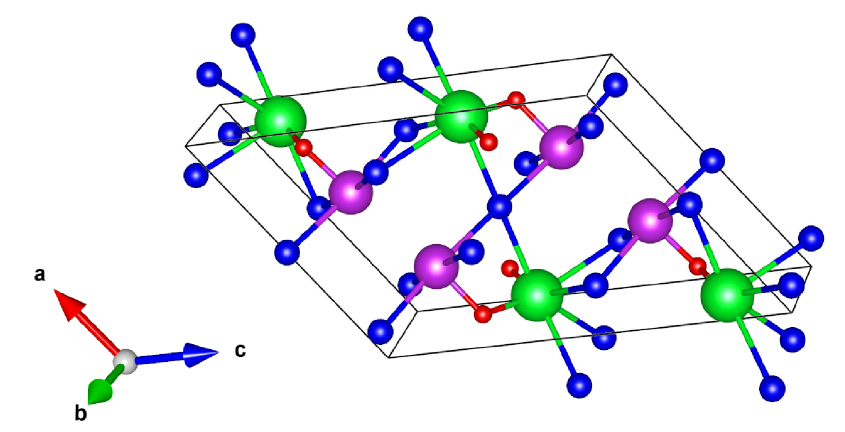
Figure 1. Crystal structure of the A 2 O 2 B 2 Se 3 (A = Sr, Ba, and B = Bi, Sb) compounds, space group P 2 1 / c (No. 14). Green, violet, red, and blue represent A, B, O, and Se atoms.